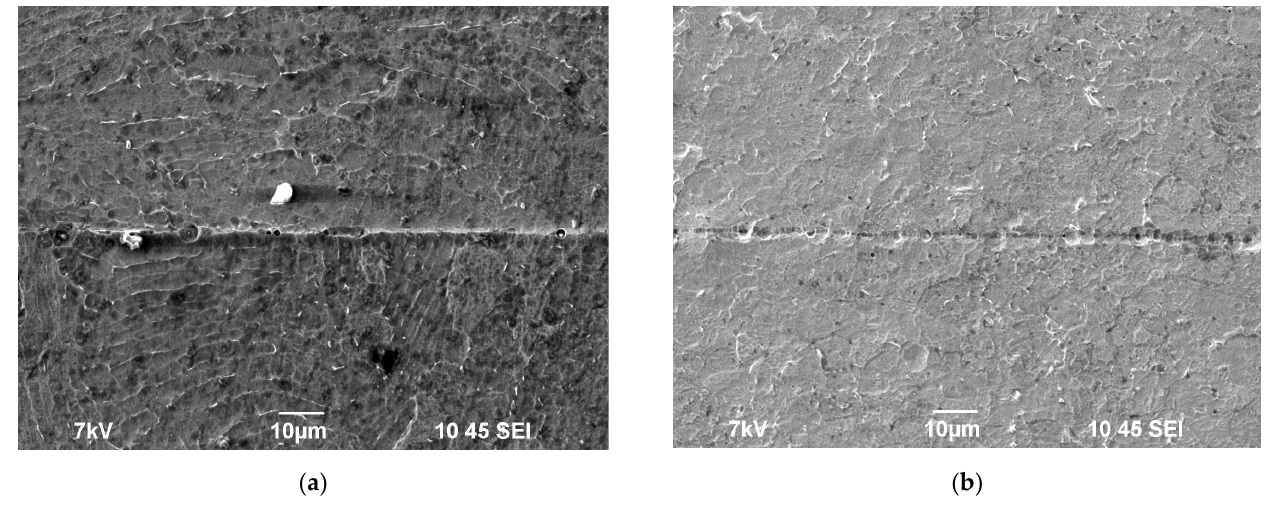
Figure 17. Surfaces of the coarse-grained ( a ) and UFG ( b ) specimens of the titanium alloy (V h = 100 °C/min, T = 600 °C, t = 10 min, P = 50 MPa) after the electrochemical testing. SEM.